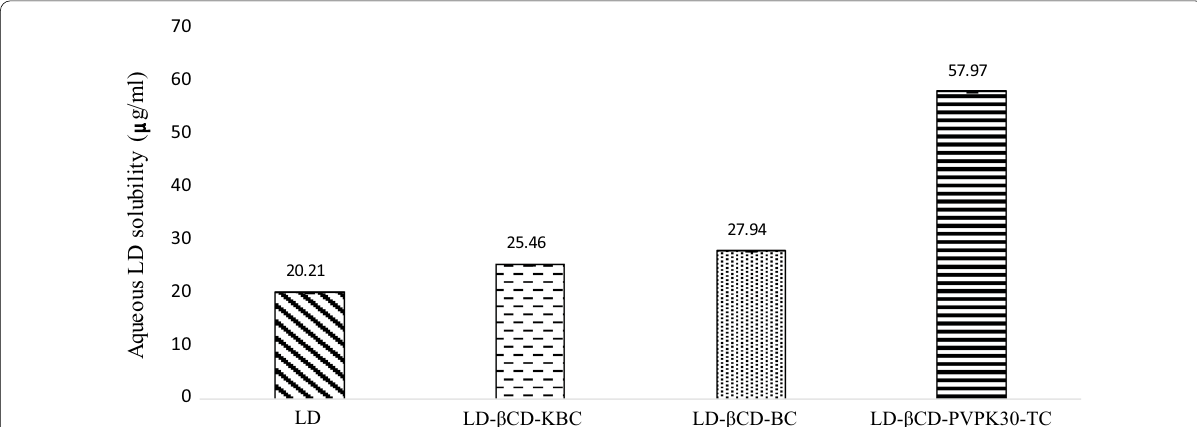
Fig. 5 The saturation solubility data of LD, kneaded binary complex (LD-βCD-KBC), freeze-dried binary complex (LD-βCD-BC) and freeze-dried ternary complex